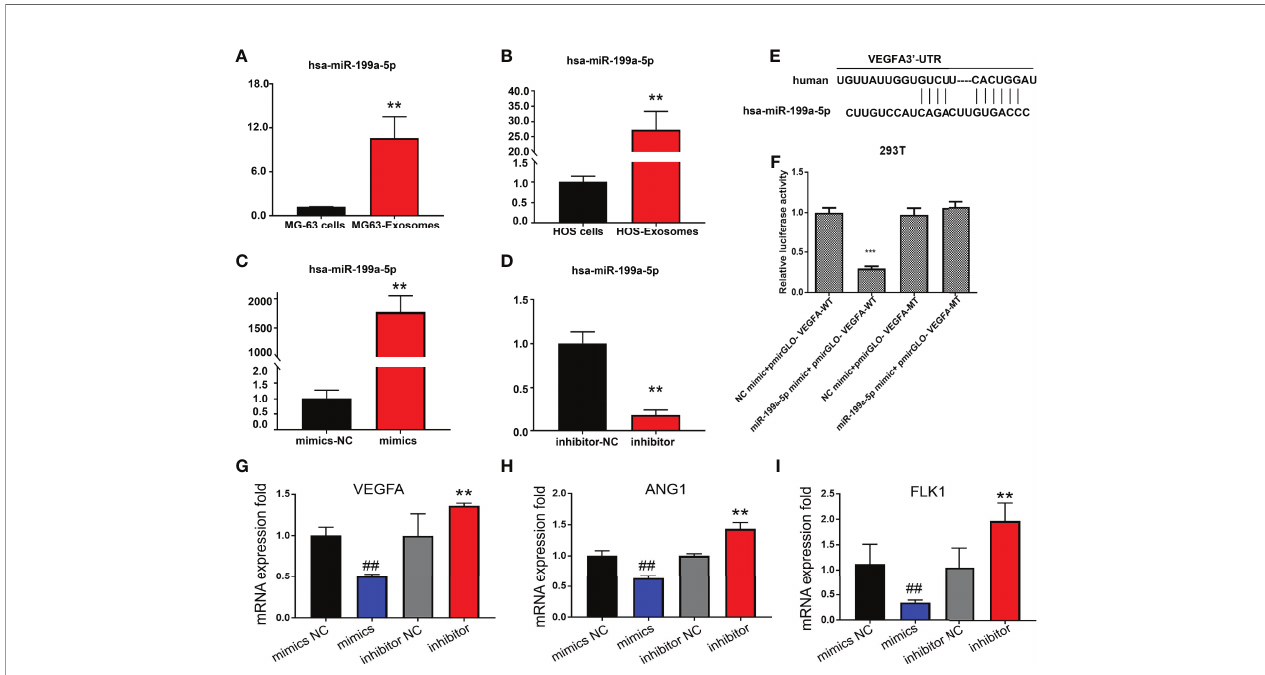
FIGURE 4 | Detection of miR-199a-5p expression level. (A) Detection of miR-199a-5p expression in MG63 cells and exosomes. (B) Detection of miR-199a-5p expression in HOS cells and exosomes. (C) Detection of miR-199a-5p expression after mimic transfection of HUVECs. (D) Detection of miR-199a-5p expression after inhibitor transfection of HUVECs. (E) Prediction of the binding sites of hsa-miR-199a-5p and VEGFA mRNA. (F) Results of double luciferase reporter gene assay. (G) Detection of VEGFA expression after mimic or inhibitor transfection of HUVECs. (H) Detection of ANG1 expression after mimic or inhibitor transfection of HUVECs. (I) Detection of FLK1 expression after mimic or inhibitor transfection of HUVECs. **P < 0.01, ## P < 0.01, ***P <